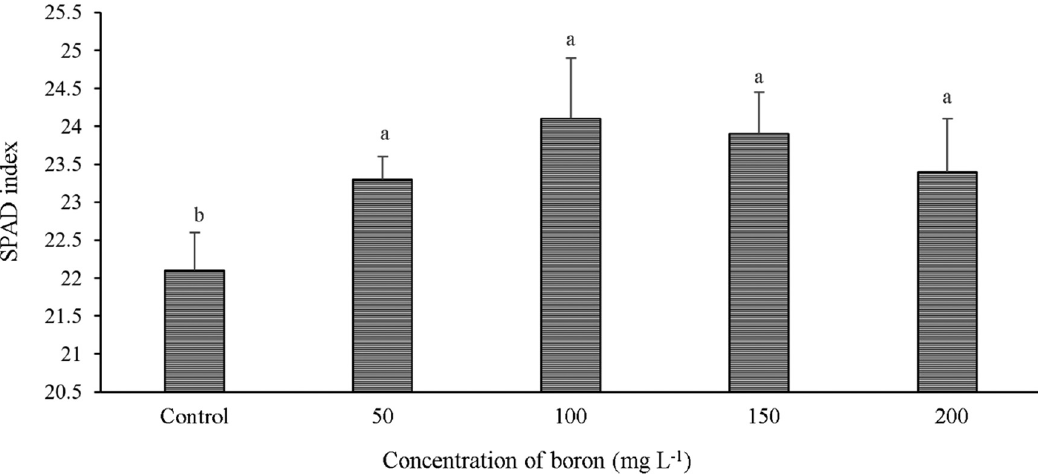
Figure 2: E ff ect of boron on the chlorophyll content in leaves. Letters within the columns represent a signi fi cant di ff erence ( P < 0.05 ) .